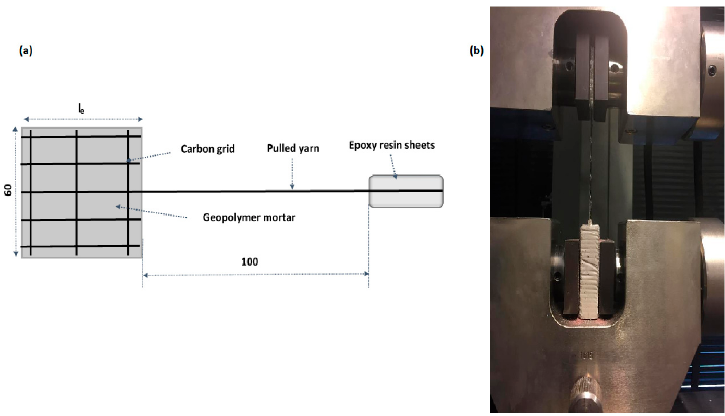
Figure 3. Schematic drawing for specimen preparation ( a ); image of pull-out test performance ( b ).